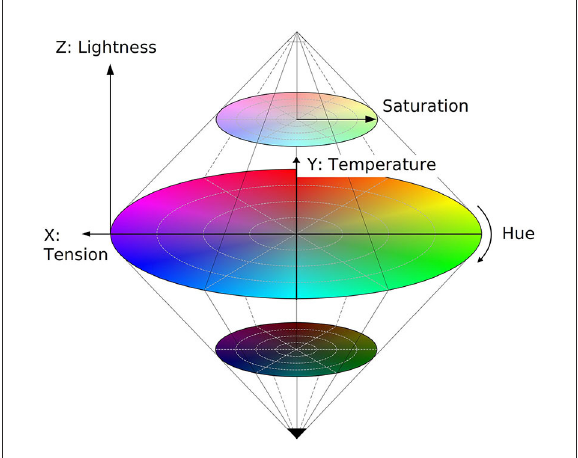
FIGURE4 Hue-saturation-lightness (HSL) color solid. Lightness defines the projection of color to the black-white axis, while hue and saturation are polar coordinates of the equatorial plane, equivalently defined by Cartesian axes temperature and tension .